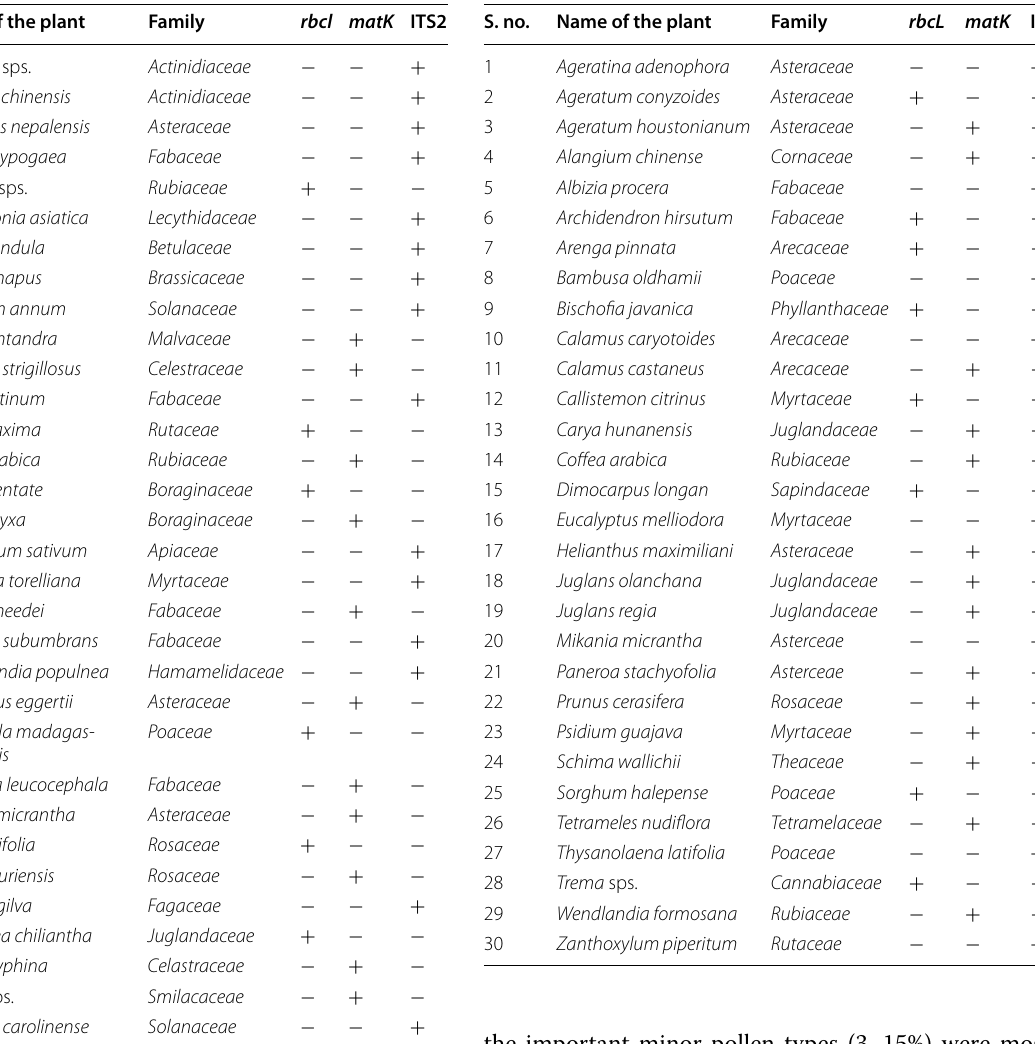
Table 4 Plant species found in the composite honey sam- Table 5 Plant species found in the composite honey